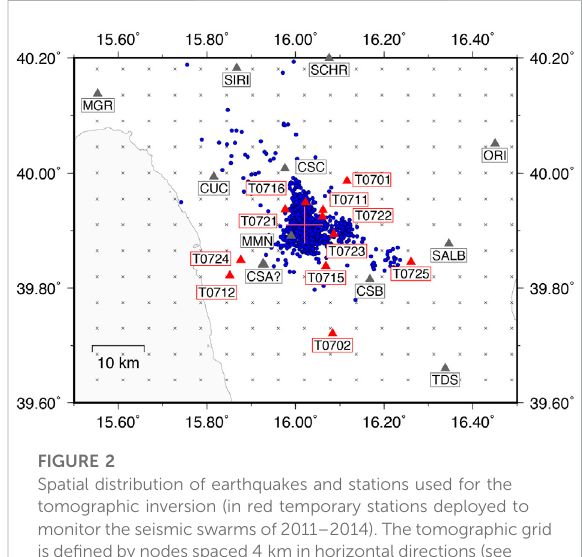
FIGURE 2 Spatial distribution of earthquakes and stations used for the tomographic inversion (in red temporary stations deployed to monitor the seismic swarms of 2011 – 2014). The tomographic grid is de fi ned by nodes spaced 4 km in horizontal directions (see crosses) and 3 km along depth. The starting velocity values assigned to each node are taken by the minimum-1D velocity model of Pastori et al.